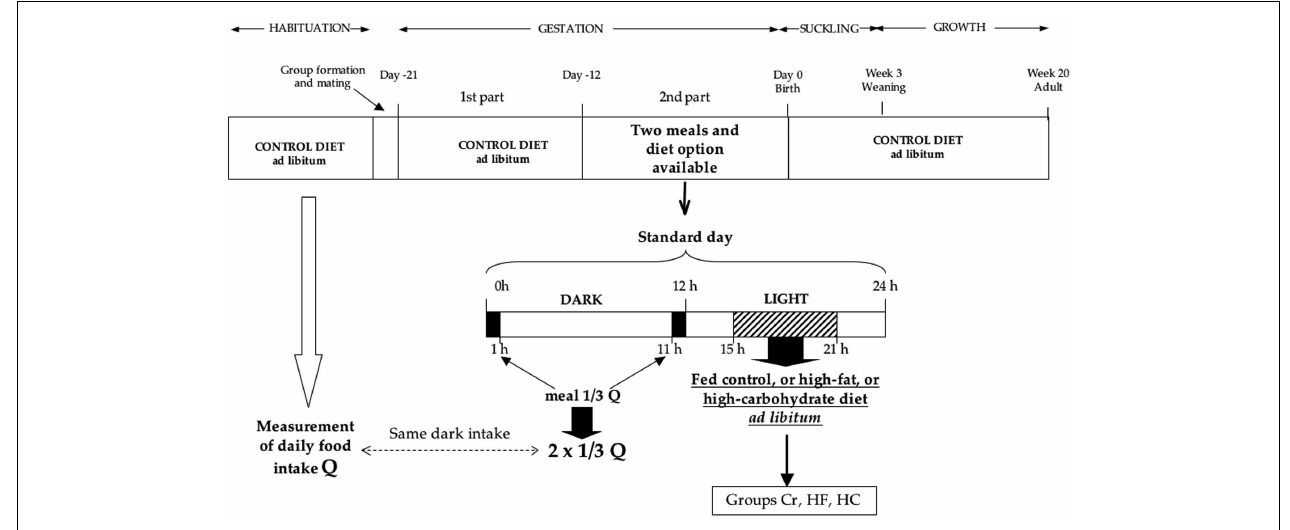
FIGURE 1 | Schematic representation of the experimental protocol.